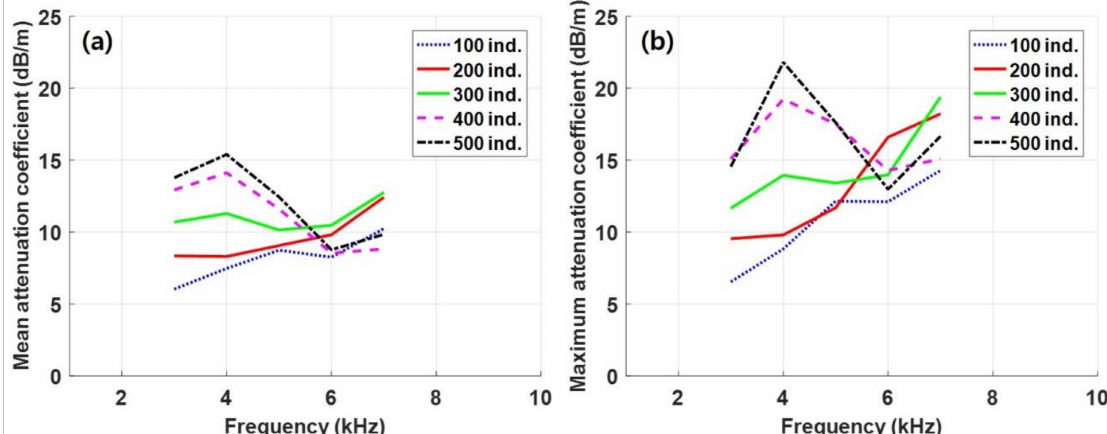
Figure 3. ( a ) and ( b ) are mean and maximum attenuation coefficients at 3–7 kHz for the different number of individual fish, respectively (100 ind.: blue dotted line, 200 ind.: red straight line, 300 ind.: green straight line, 400 ind.: pink dashed line, and 500 ind.: black dashed